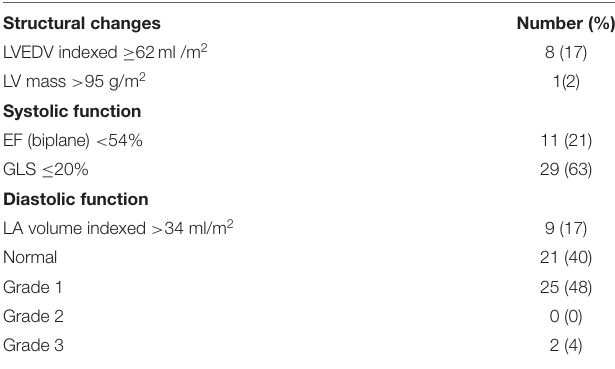
TABLE 4 | Echocardiography abnormalities in 53 women with DMD gene aberrations. Structural